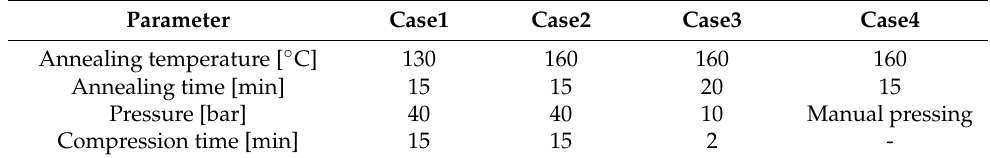
Table 1. Parameters for preparation of the composite plates with a single fiber layer. Testing was performed on composites made using the parameters applied in Case 3. Parameter Case1 Case2 Case3 Case4 Annealing temperature [ ◦ C] 130 160 160 Manual pressing Compression time [min]